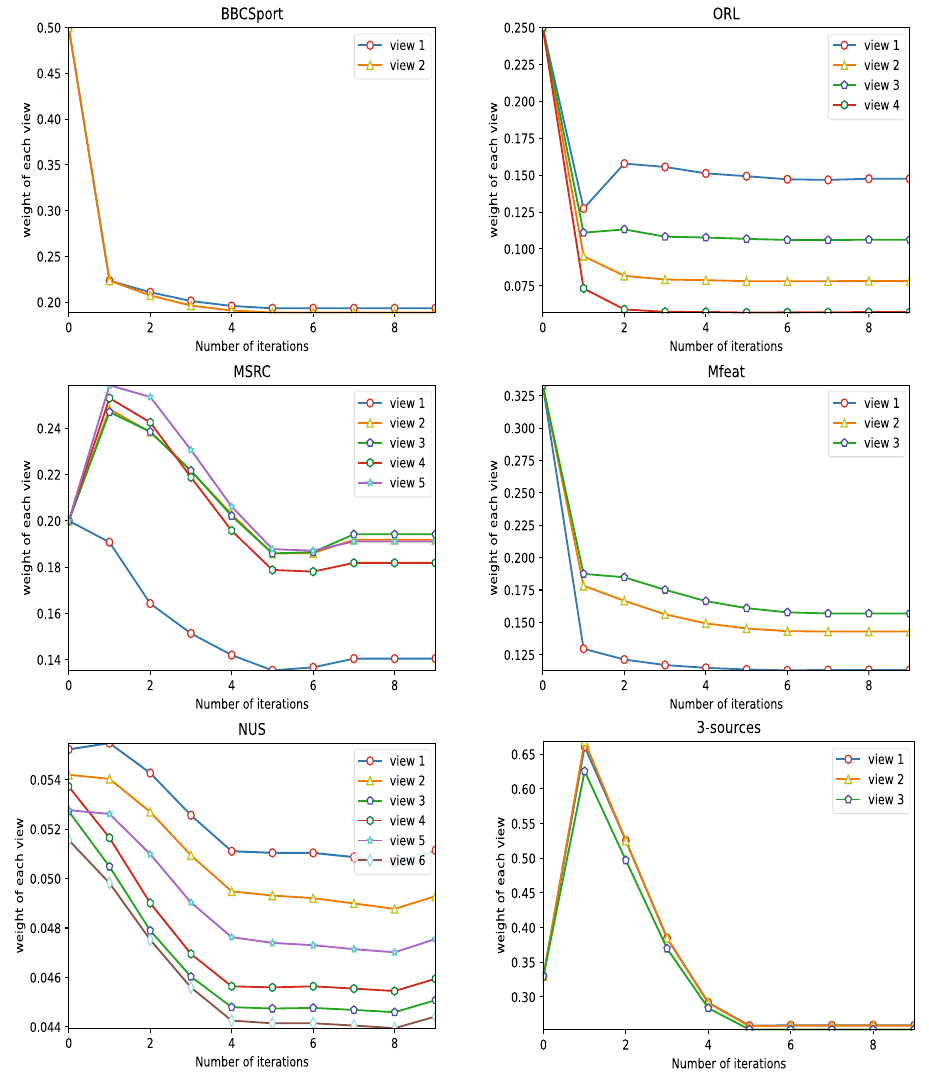
Figure 3. The weight change of each view in the optimization process by algorithm 1.